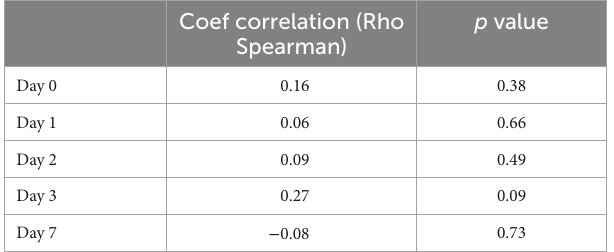
TABLE 7 Correlation of IL-10 with leukocytes.